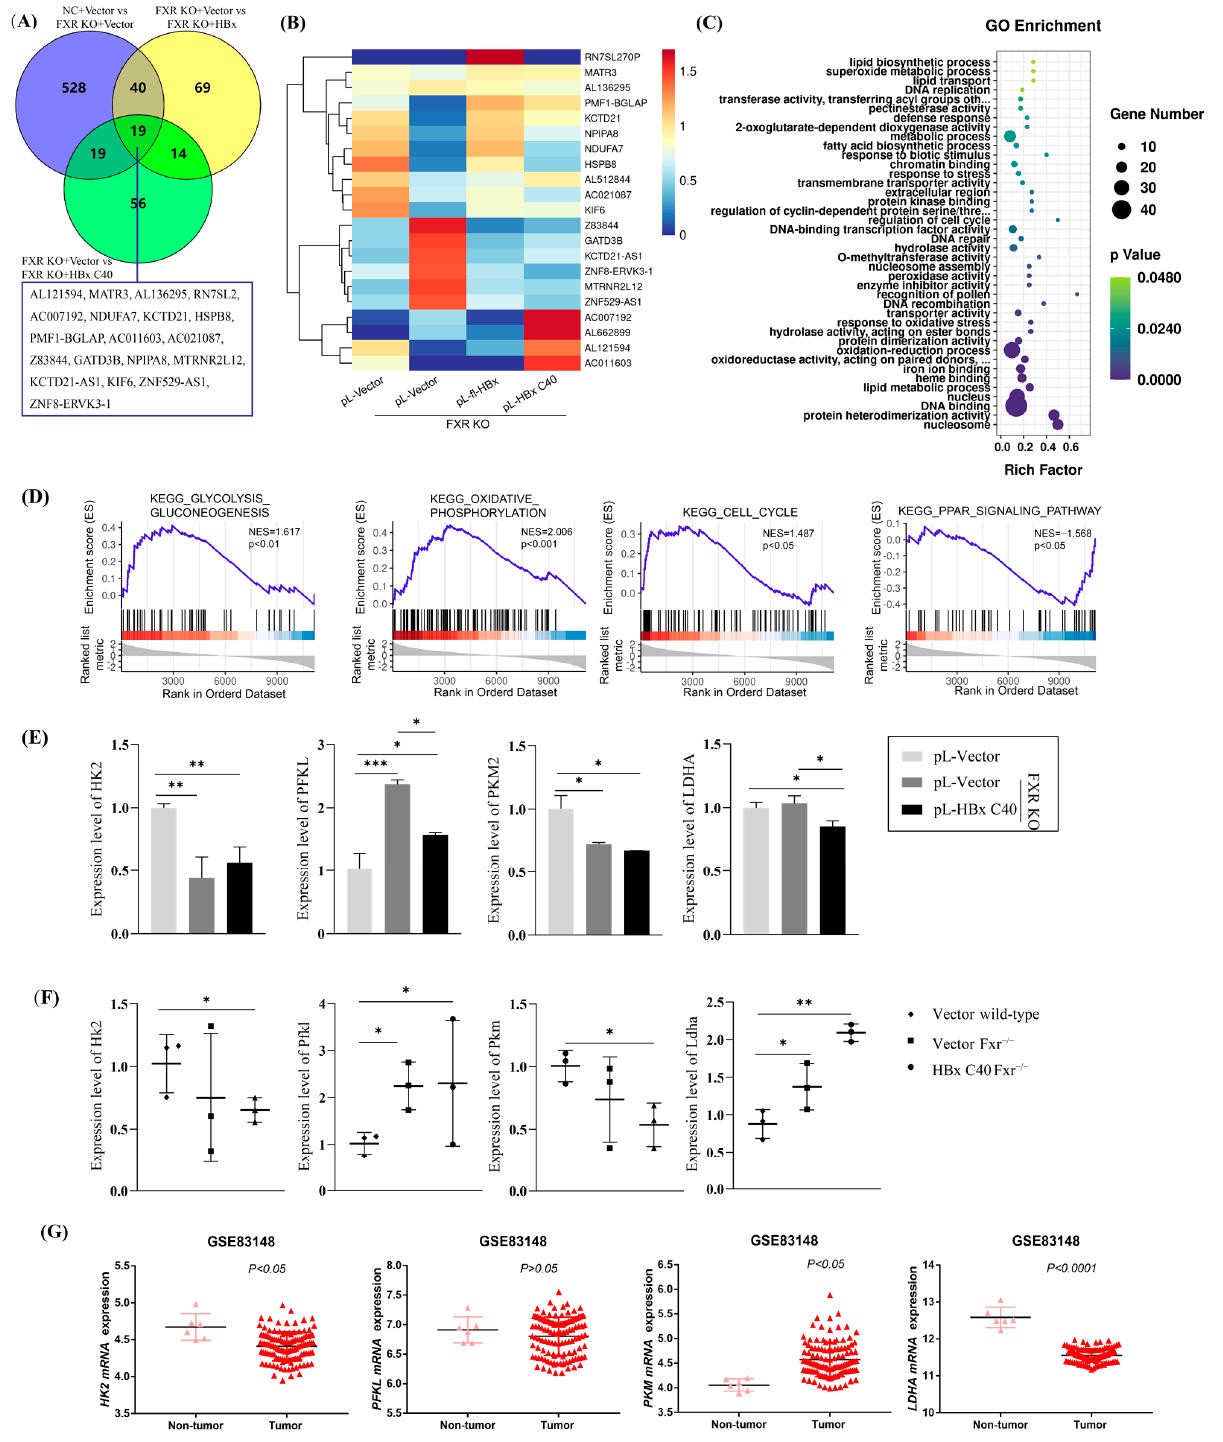
Figure 6. RNA sequencing identifies signaling pathways and crucial targets in HBx C40-expressing, FXR-deficient Hep3B cells. ( A ) DEGs are common among the NC vs. FXR KO Hep3B, FXR KO vs. FXR KO + HBx Hep3B, and FXR KO + HBx vs. FXR KO + HBx C40 Hep3B groups. ( B )